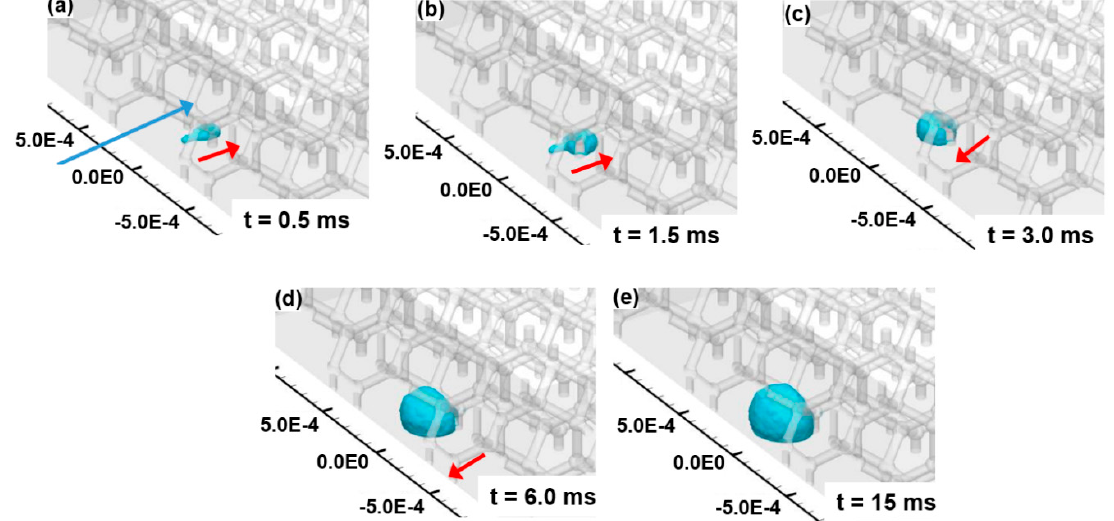
Figure 7. Liquid water penetration length for foam B.